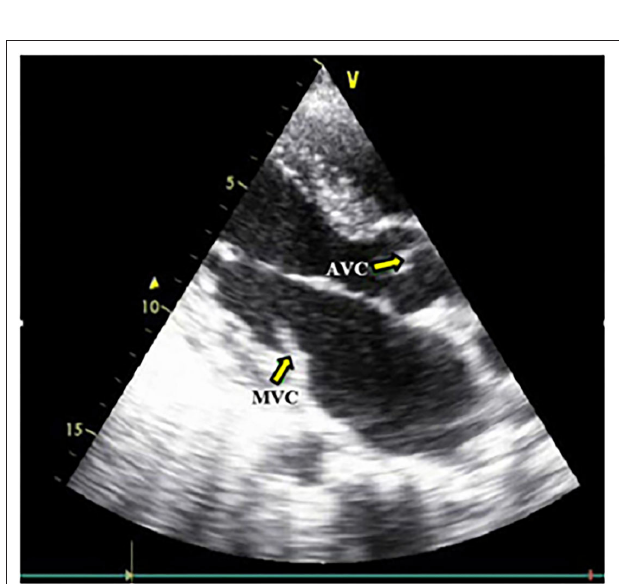
due to the different method used for measurement of VC in a different site in the latter study